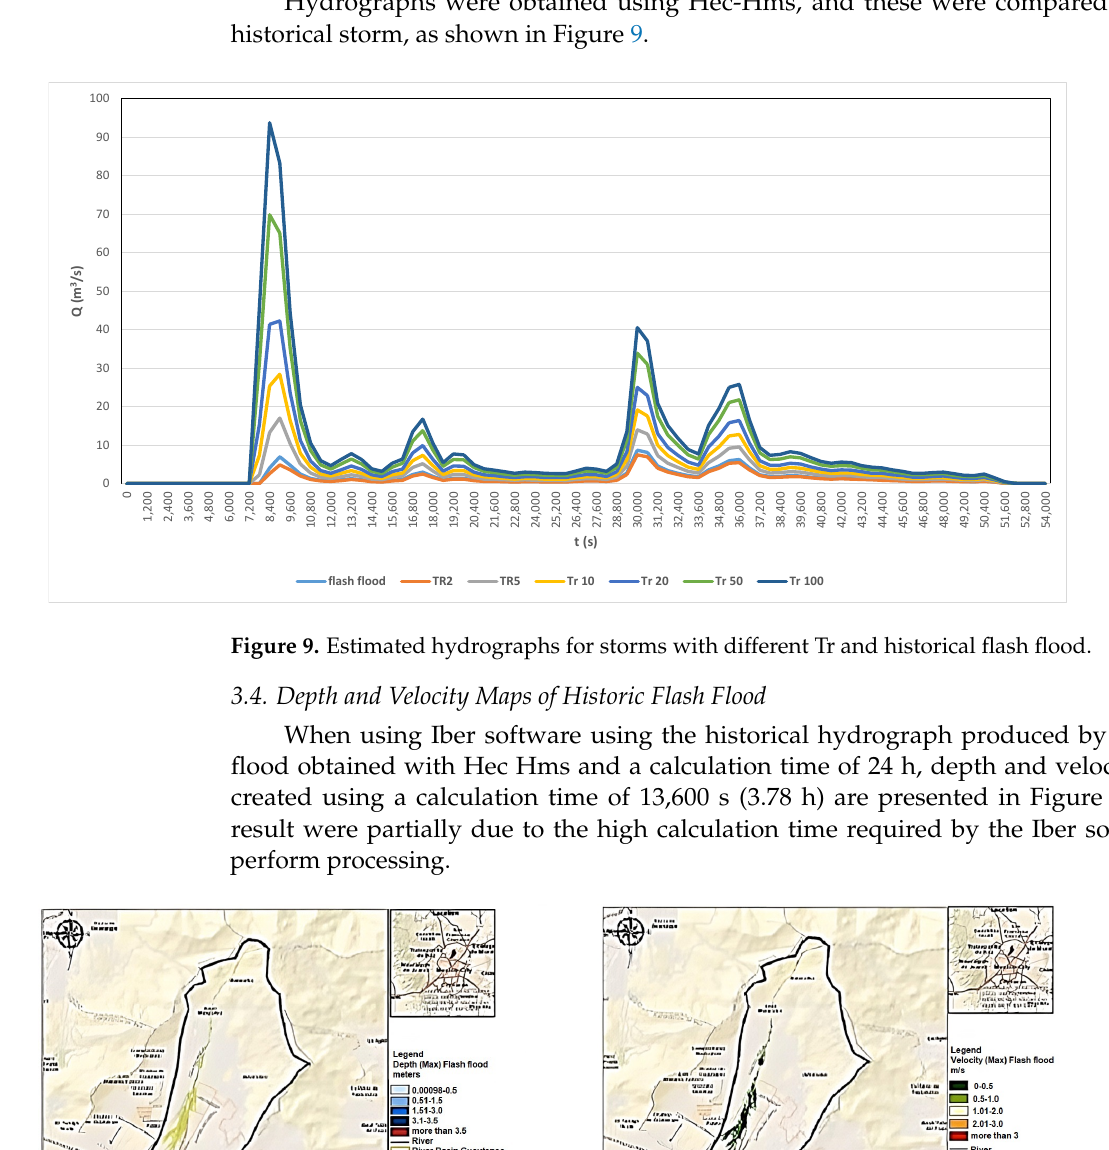
Figure 8. Flash flood hydrograph produced by the historic storm of September 2021. Estimated with Hec ‐ HMS. Cuauhtepec Basin, Edomex.